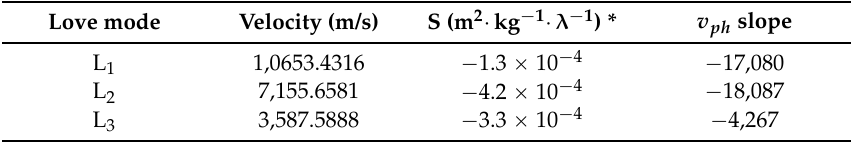
Table 2. Love mode orders, phase velocity, gravimetric sensitivity values S and the phase velocity slope: the data are referred to Love modes travelling at different velocities along the same ZnO layer thickness ( h / λ =